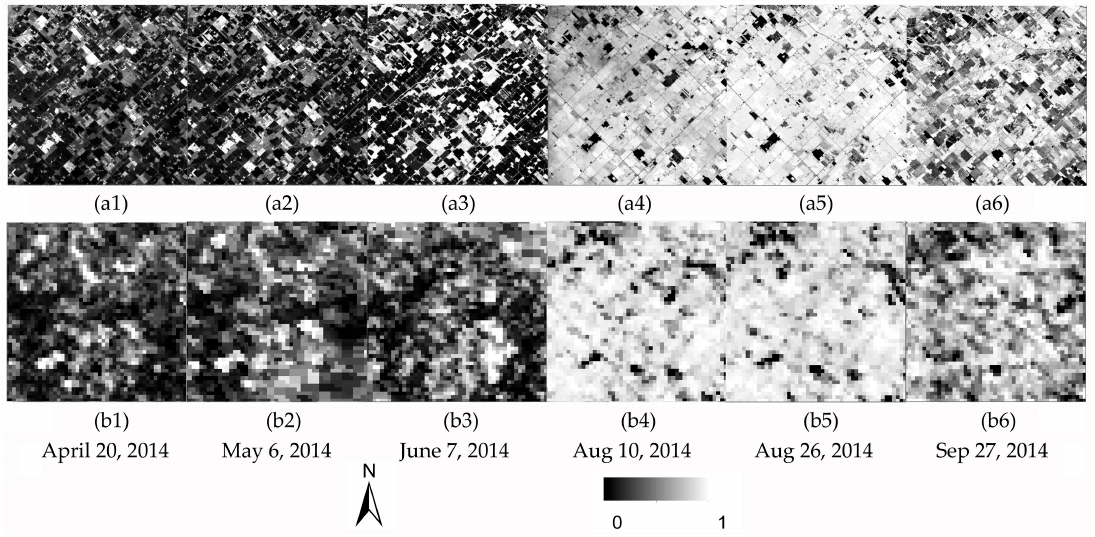
Figure 7. The Landsat and MODIS NDVI image pairs acquired throughout the growing season in Ontario, Canada.